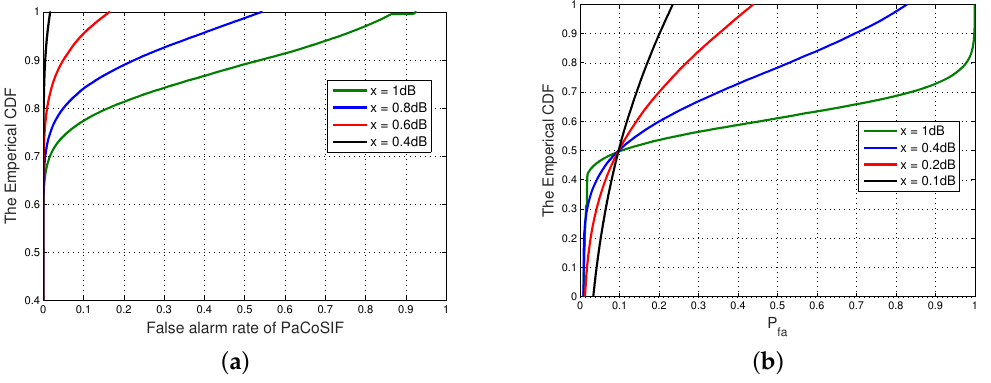
Figure 8. The distribution of the false alarm rate under different noise uncertainties. ( a ) ∆ ρ = 4 dB; ( b ) ∆ ρ = − 4 dB.